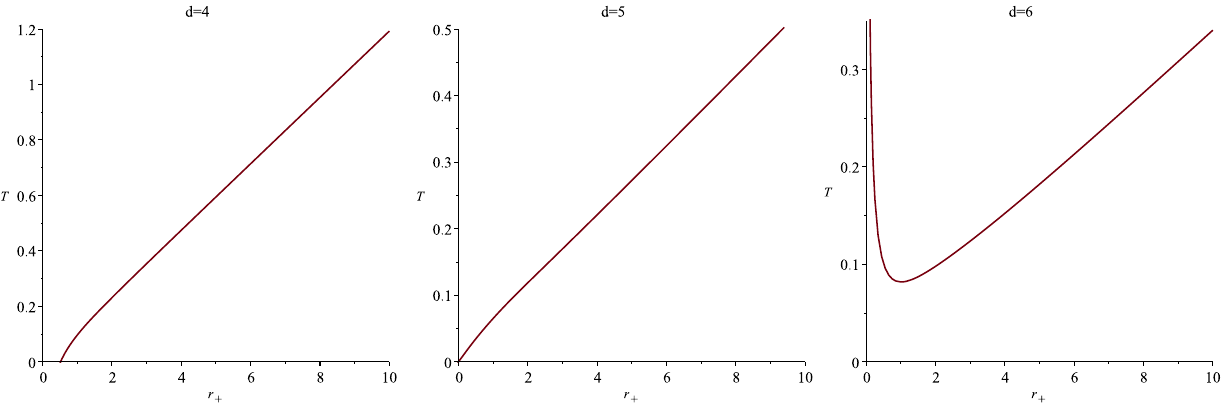
Fig. 1 Behavior of the temperature T as function of the horizon radius r + , corresponding to d = 4, d = 5, and d = 6. We set (cid:2) = 0 . 5 and (cid:7) = − 1 in all three W